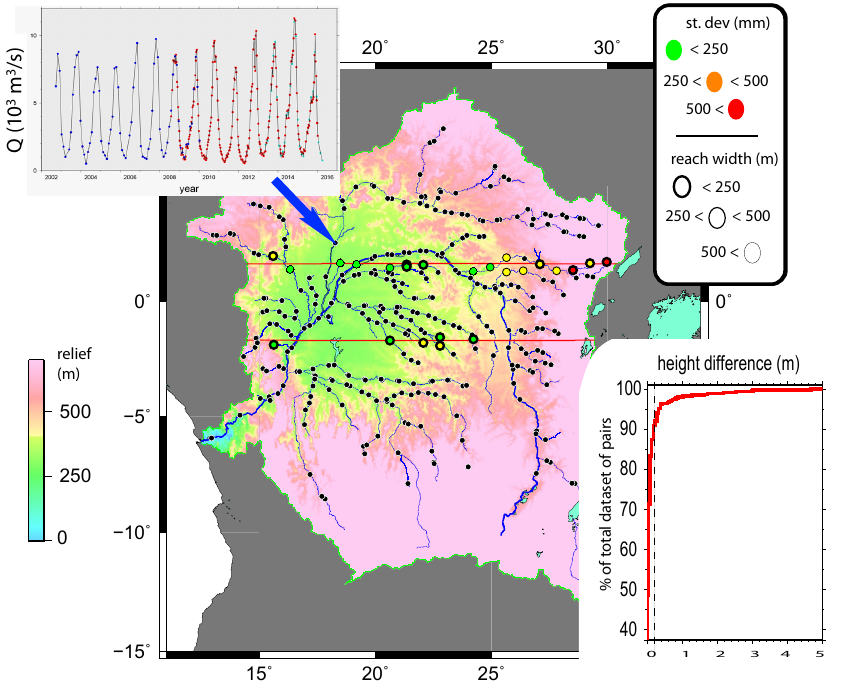
Figure 17. The Congo basin. The locations of the 350 SARAL/AltiKa Virtual Stations are shown with black dots. The +1.595 ◦ and − 1.677 ◦ parallels in red are where the SARAL/AltiKa orbit forms crossover at 1.5 day temporal difference. The Virtual Stations used for the accuracy assessment at cross-overs are coded according the standard deviation between the two SARAL/AltiKa series of water level and the reach width, as recalled in the upper right inset. The cumulative histogram of the differences between measurement pairs is shown in the lower right inset. The dotted bar outlines the value of 20 cm in difference achieved by 90% of the population of height pairs. An example of Envisat + Jason-2 + SARAL/AltiKa discharge series on the Ubangui River derived from the rating curve established combining SARAL/AltiKa levels and MGB discharge is presented in the left hand